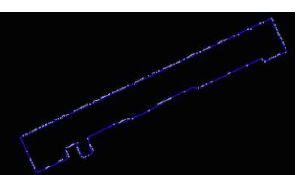
Figure 6. Building’s Outline extraction by implementation of Canny operator (white polyline) and Douglas-Pocker algorithm